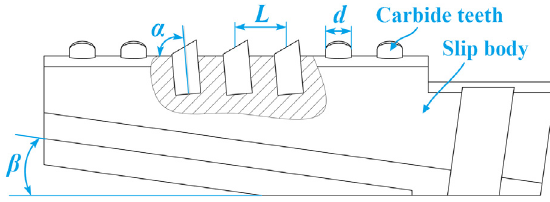
Figure 15. Distribution of bite depth of each tooth.